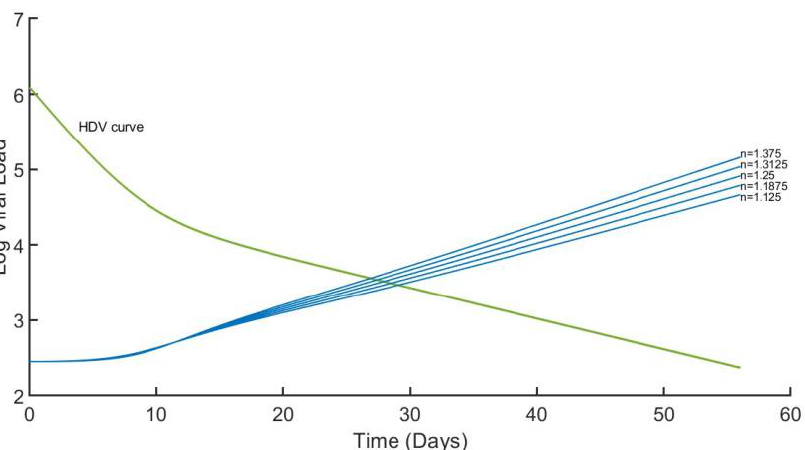
Figure A2. One-way sensitivity analysis on the impact of parameter n on predicted HBV/HDV kinetics under anti-HDV treatment. Model parameters were set to D 0 = 1,202,260, B 0 = 282, κ = 26,137, c = 0.47, g = 0.094, τ = 0.1, and ε = 0.97, with n being set at n = (1.125, 1.1875, 1.25, 1.3125, 1.375). HDV predicted kinetics were not affected by different n values.